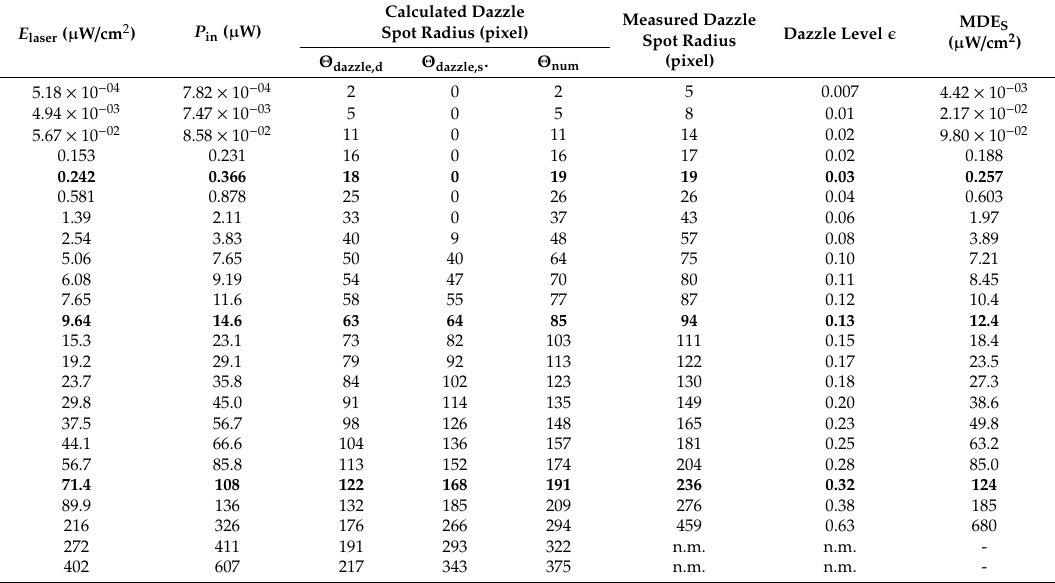
Table A4. Calculated and measured dazzle spot size using Setup 2 (see Section 6.2) for a laser wavelength of 640 nm. Abbreviation: n.m.: not